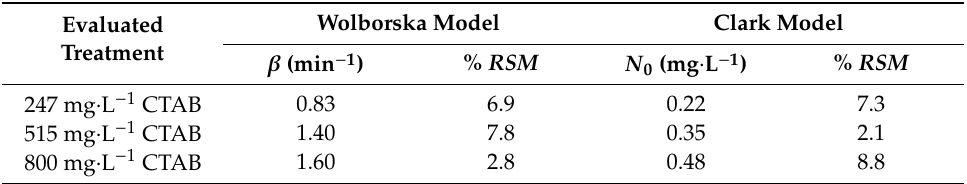
Table 5. Answer parameters of Clark [48] and Wolborska [49] models for treatments evaluated varying the concentration of adsorbed CTAB.